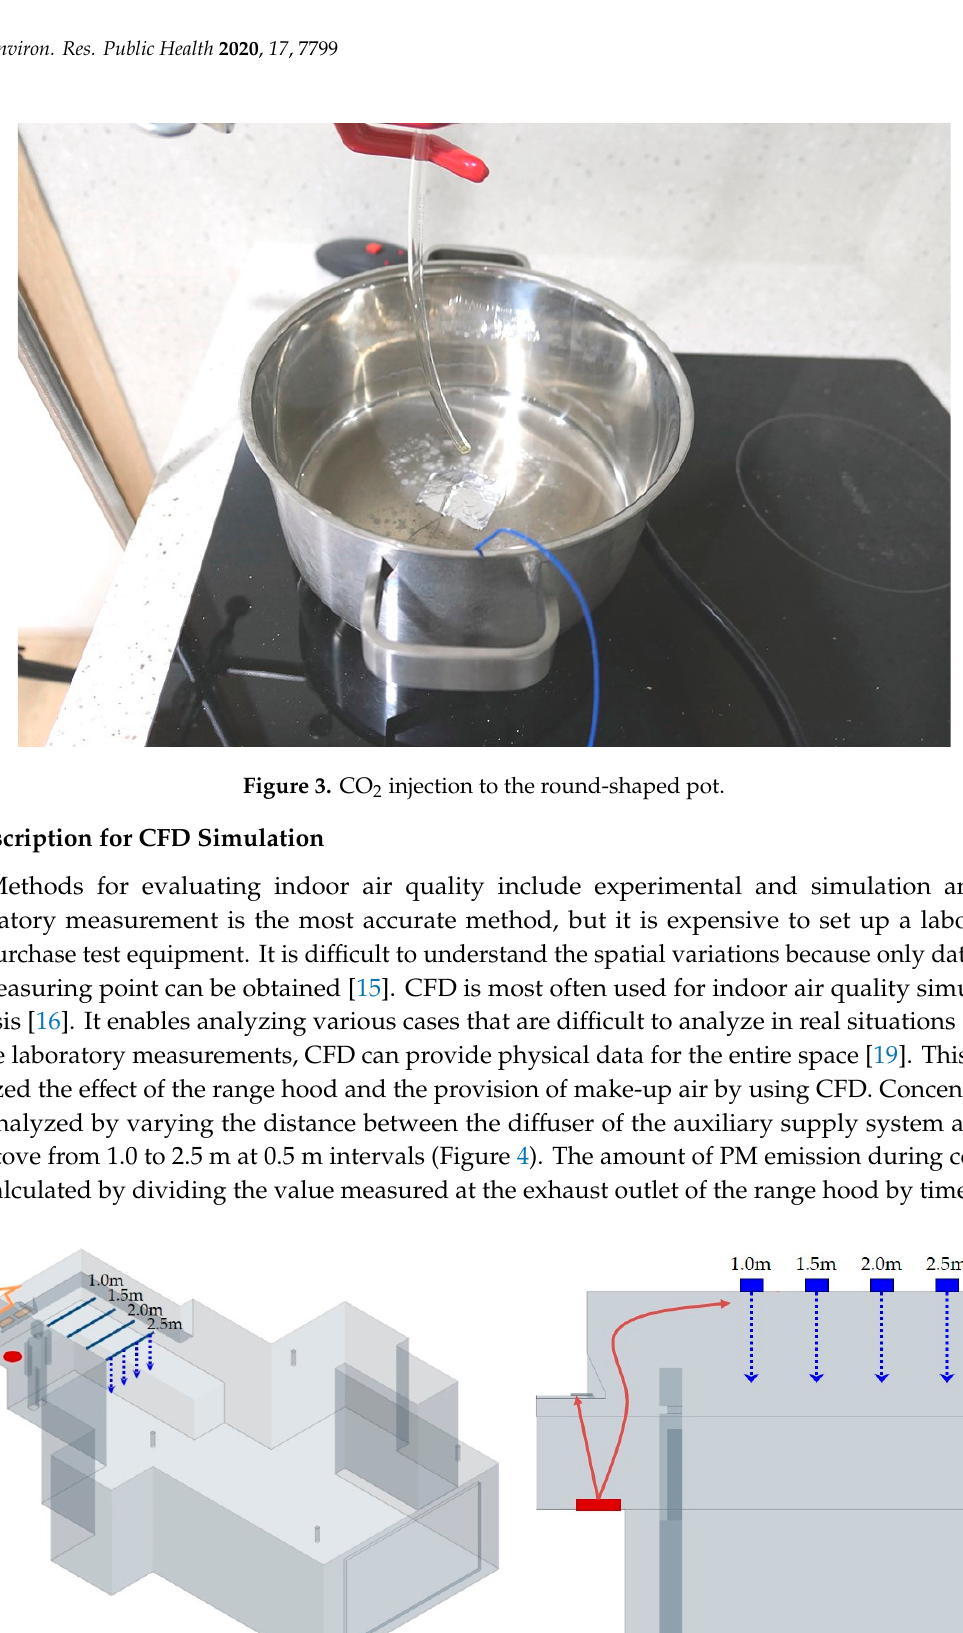
Figure 4. CFD simulation model and location of the supply air diffuser: ( a ) perspective diagram of kitchen hood and supply diffuser; ( b ) vertical section diagram of the location of the supply diffuser.